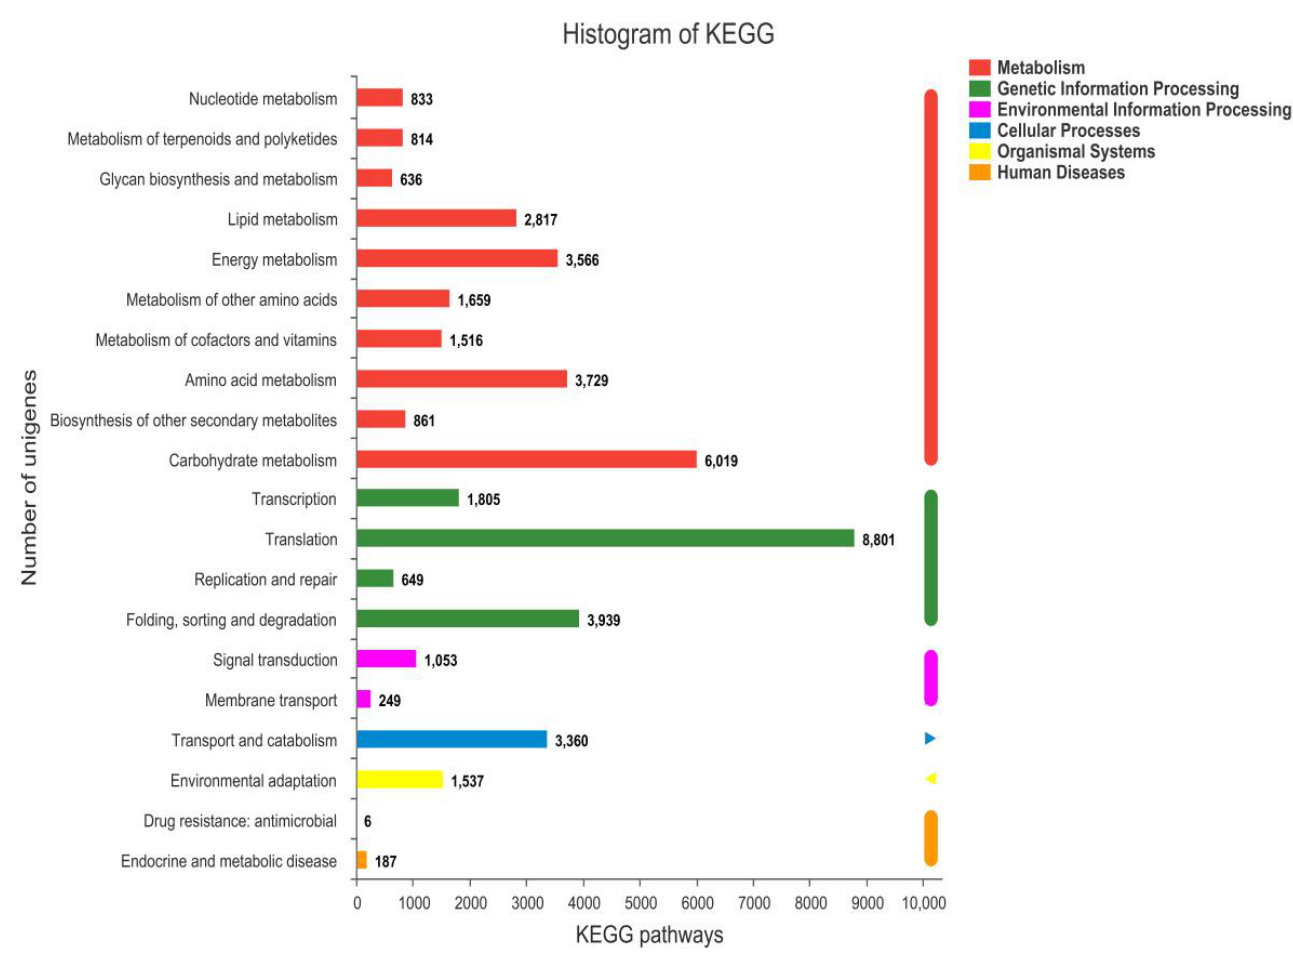
Figure 2. KEGG pathway classification statistics.